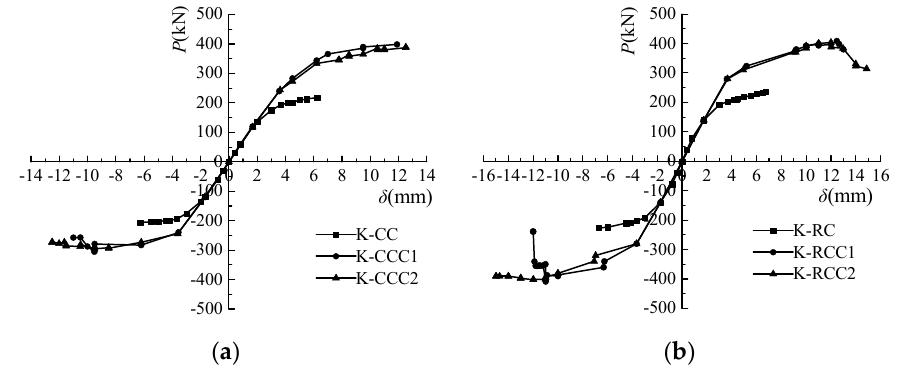
Figure 8. Skeleton curve of P - δ . ( a ) Joints with a circular chord and brace; ( b ) joints with a square chord and circular brace. Table 3. Ductility coefficient of joints.